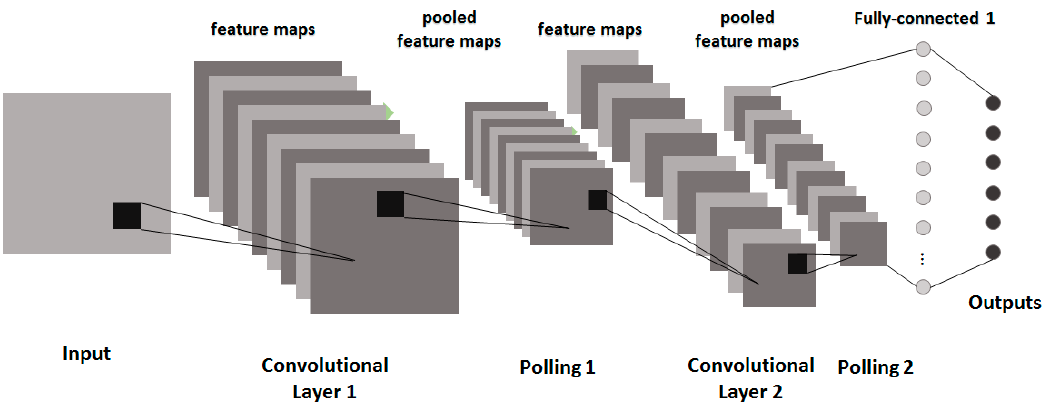
Figure 4. The network structure of a CNN.